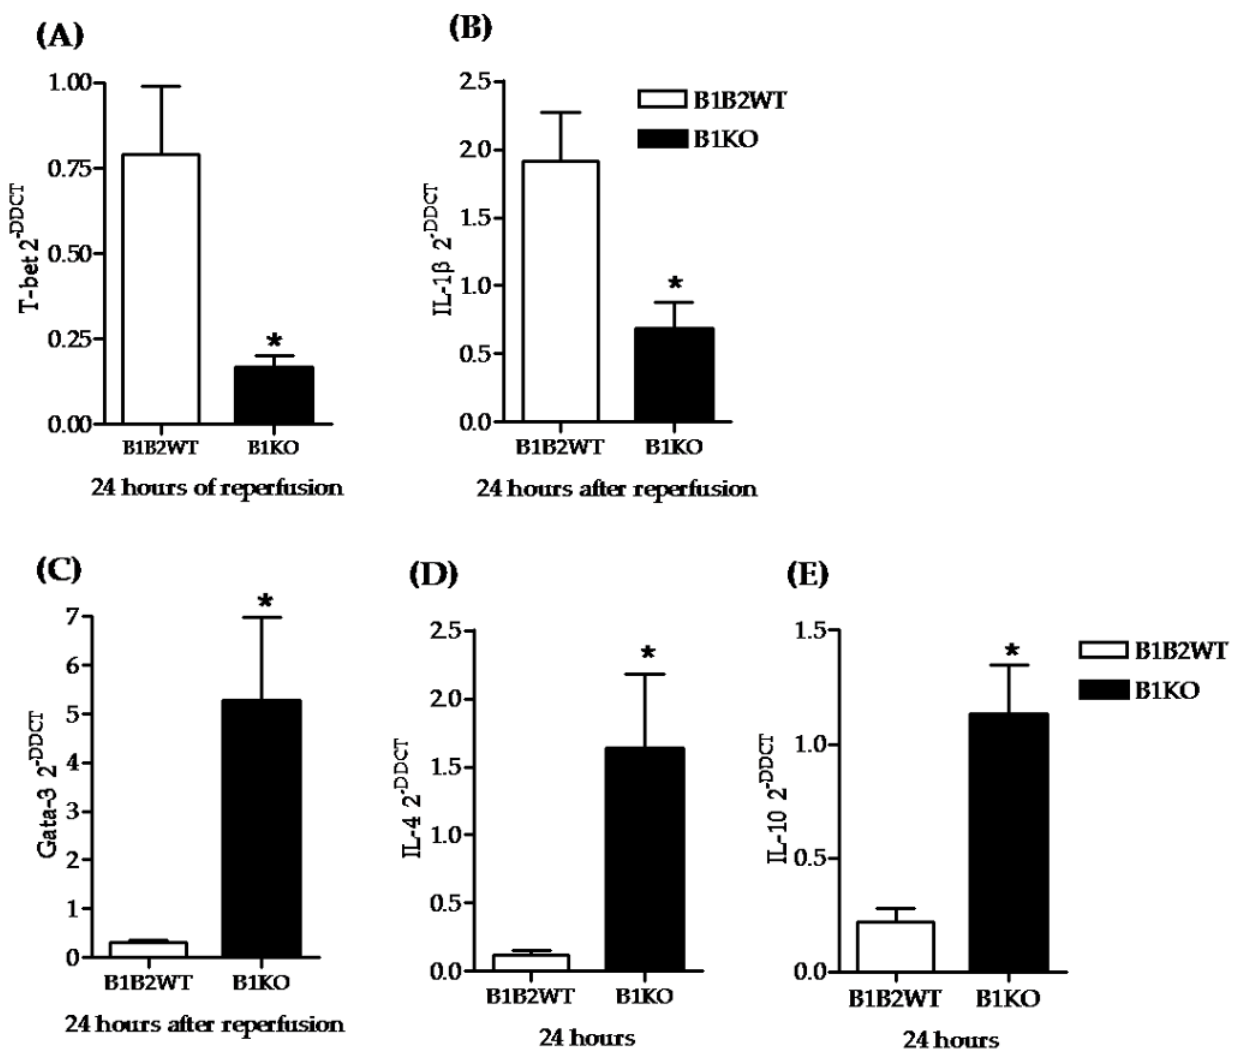
Figure 4. Pro and anti-inflammatory molecule expression in B1KO and wild type animals. All molecule expressions were measured by real-time PCR at 24 hours of reperfusion. B1KO group had lower pro-inflammatory molecule expression (T-bet and IL-1 b ) (A and B) and higher anti- inflammatory response (GATA-3, IL-4 and IL-10) (C, D and E). Statistical analyses were performed using the t-test.* B1KO versus B1B2WT, p , 0.05.